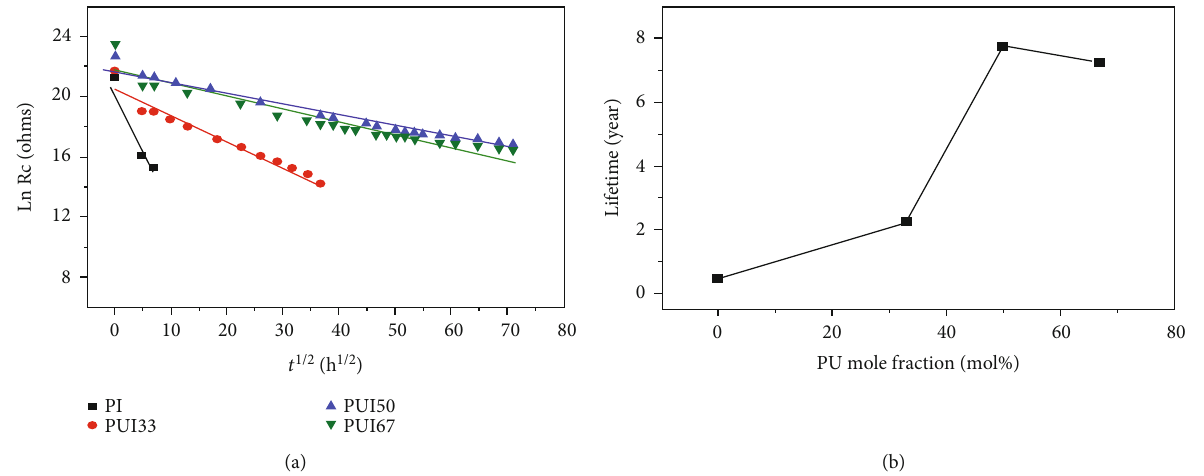
Figure 10: Polyimide-b-polyurea supramacromolecule.